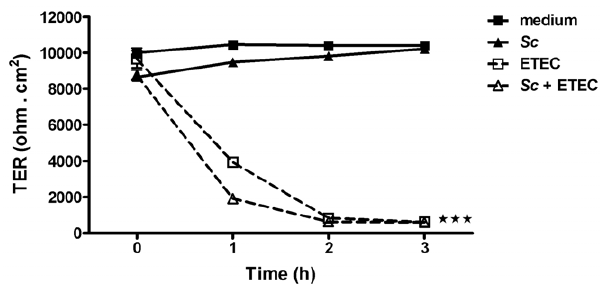
Figure 7. Saccharomycescerevisiae failed to preserve the barrier function. Measurement of transepithelial electrical resistance (TER) in differentiated IPEC-1 cells untreated, pre-incubated with Sc (3 6 10 6 yeasts/well), exposed to ETEC (3 6 10 7 CFU/well) or pre-incubated with Sc and then exposed with ETEC. Data are presented as means 6 SEM, ( n =4). Data are representative of two independent experiments, asterisks denote: *** ( P , 0.001 ).